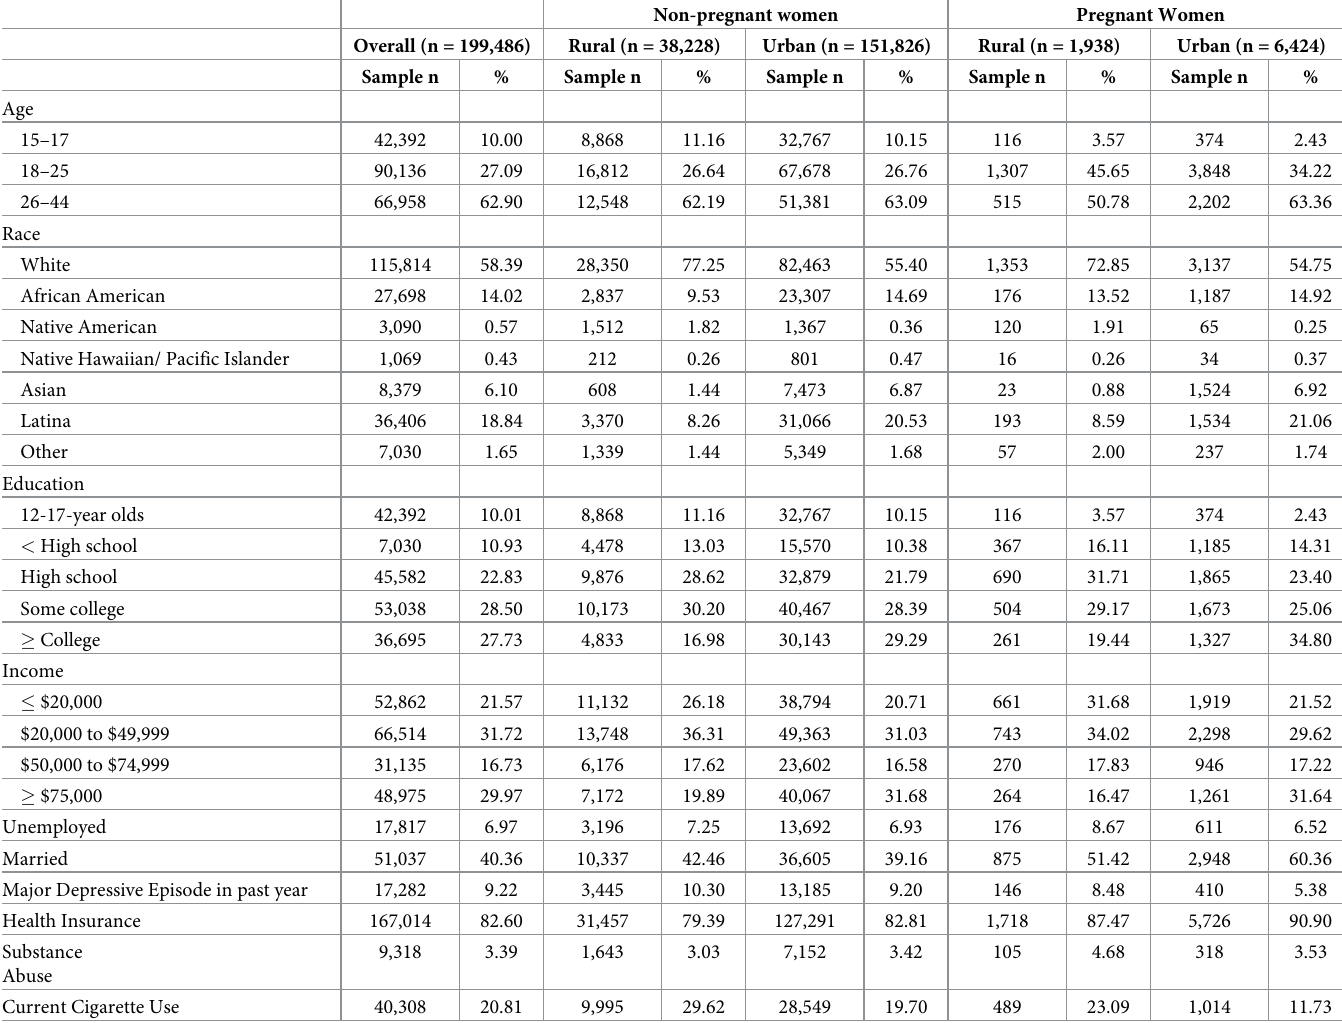
Table 1. Descriptive statistics of the combined 2007–2016 sample of women of reproductive age (national survey on drug use and